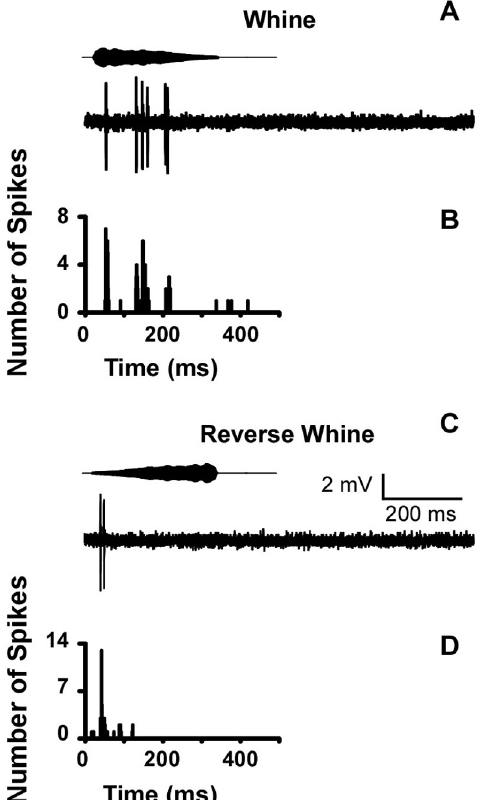
Fig 5. Example of a whine sensitive cell with reduced sensitivity to reversed whine. Panels are spike trains in responses to single presentations and peristimulus time histograms for 20 repetitions of the (A, B) natural whine and (C, D) reversed whine (time-waveforms of stimuli above voltage